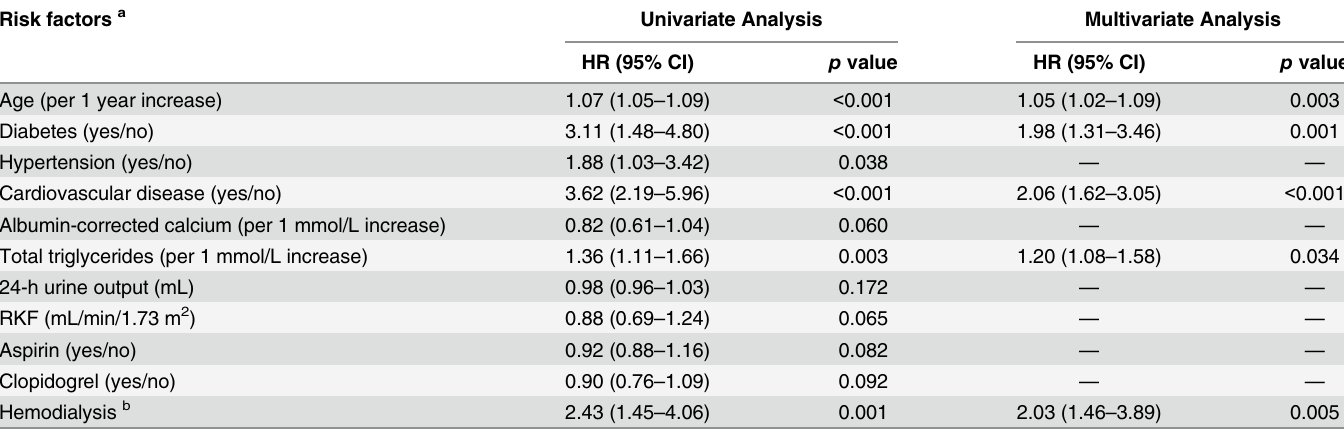
Table 5. Risk factors for stroke in all dialysis